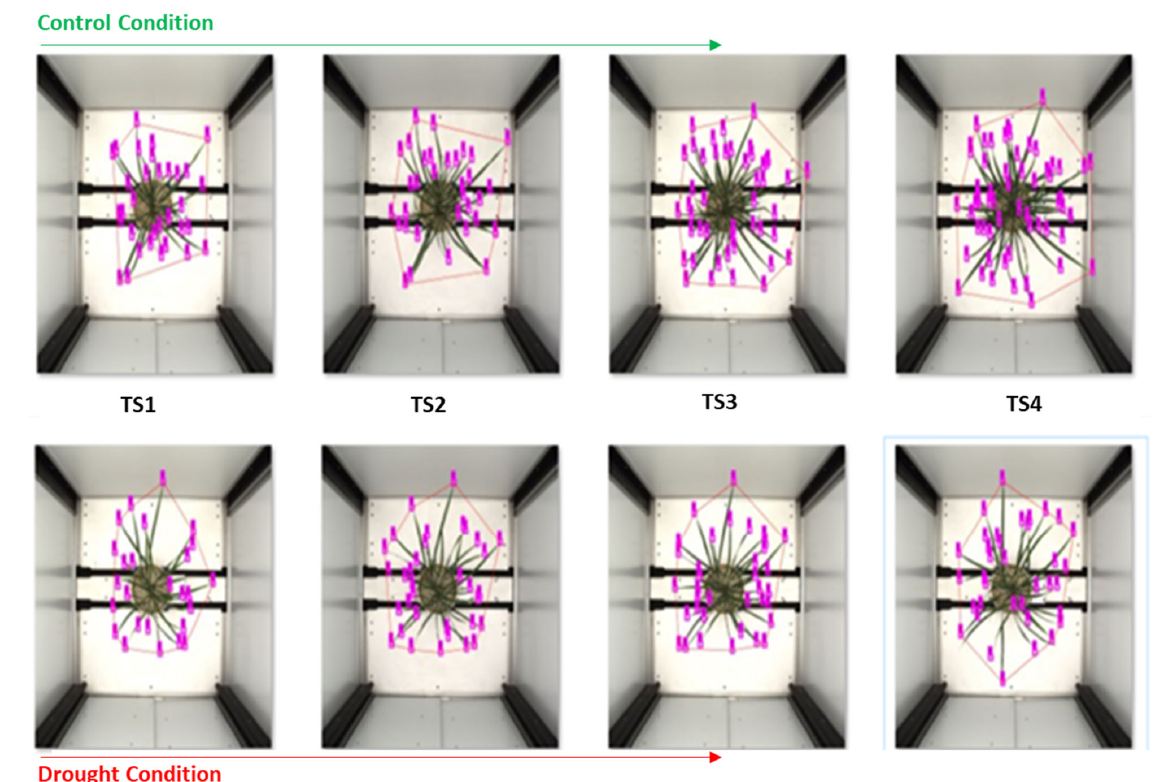
Figure 9. Convex hull and convex hull area estimation by predicting leaf tip and its coordinate without removing the background, and tip coordinates are used for convex hull estimation. Here, a genotype in drought and control conditions: in control, a large number of leaf settings are observed, compared with the stressed plant; also, no leaf rolling and a large convex hull area in the control plant is observed, compared with the drought-stressed plant with a smaller number of leaves, leaf rolling and comparatively less convex hull area.